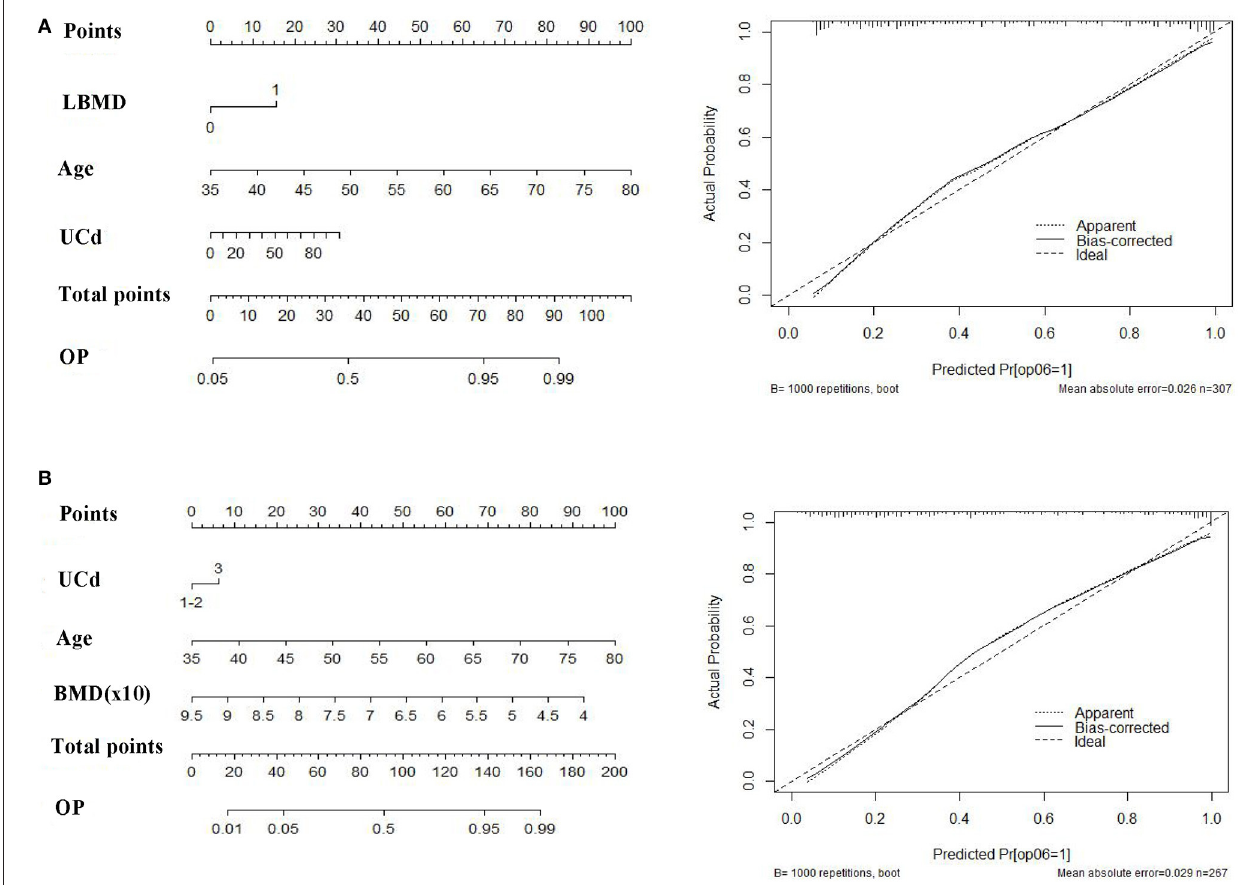
FIGURE 3 | The nomograms (right) and calibration curves (left) to predict follow-up osteoporosis in all population (A) and women with normal baseline bone mineral density (BMD) (B) . Age, UCd (quantitative data) and presence of low BMD (0, no; 1, yes) were included for total population. Age, UCd (qualitative data) and baseline BMD (quantitative data) were included for women with normal baseline BMD. UCd was divided into three groups: 0–5 (1), 5–10 (2), and > 10 µ g/g creatinine (3).